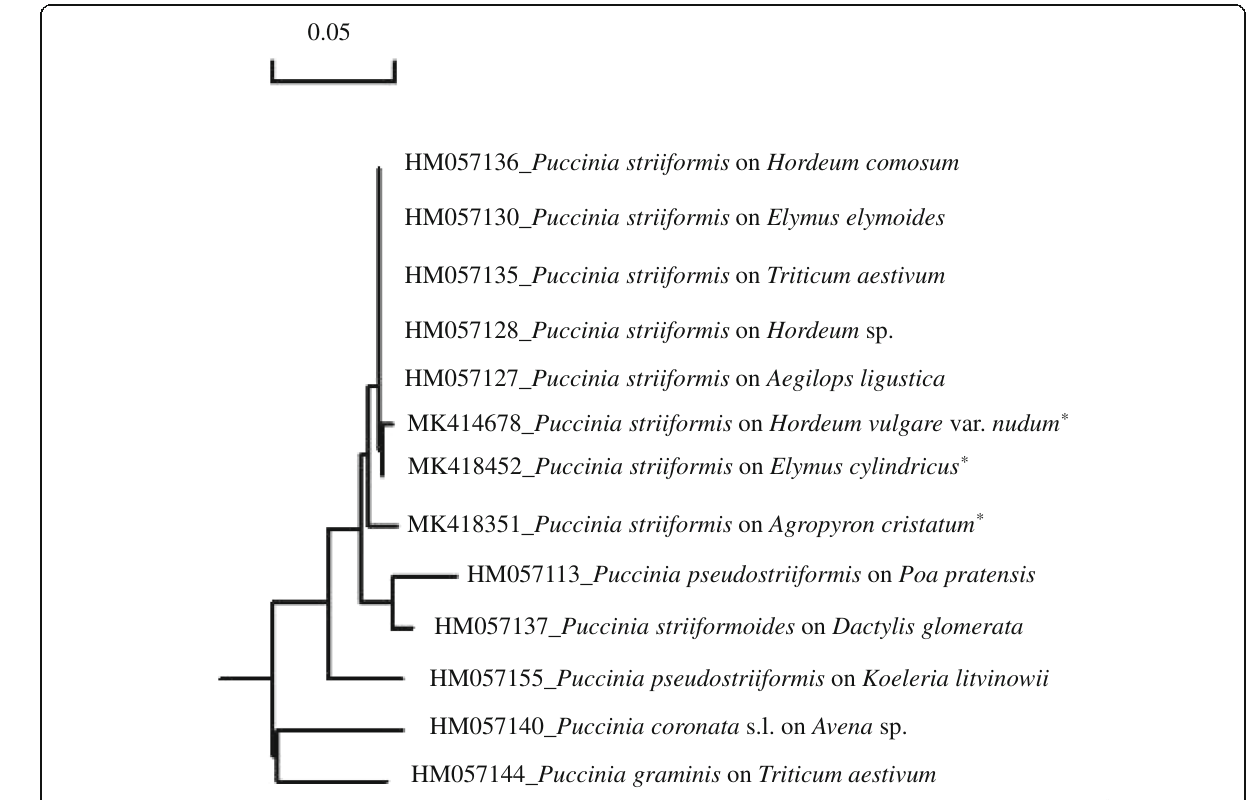
Fig. 3 Phylogenic tree based on ITS sequences of three formae speciales of Puccinia striiformis and the related species in Puccinia . * P. striiformis f. sp. hordei on Hordeum vulgare var. nudum (GenBank accession No.:MK414678), P. striiformis f. sp. elymi on Elymus cylindricus (GenBank accession No.:MK418452) and P. striiformis f. sp. agropyri on Agropyron cristatum (GenBank accession No.:MK418351). The related Puccinia species submitted at NCBI Database (https://www.ncbi.nlm.nih.gov/) were used as